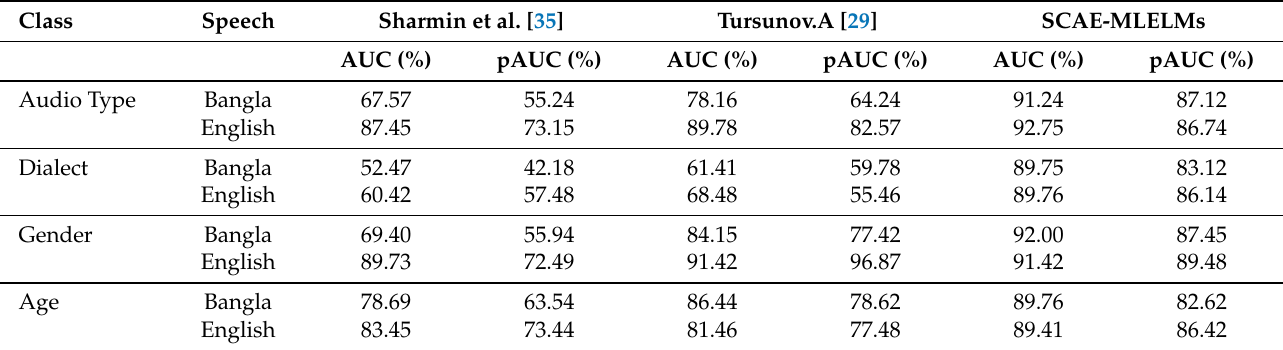
Table 10. Performance Results of existing methods; Sharmin et al. [35]: Deep CNN, and Tursunov [29]; Multi-attention module CNN model for MFCCs data type.